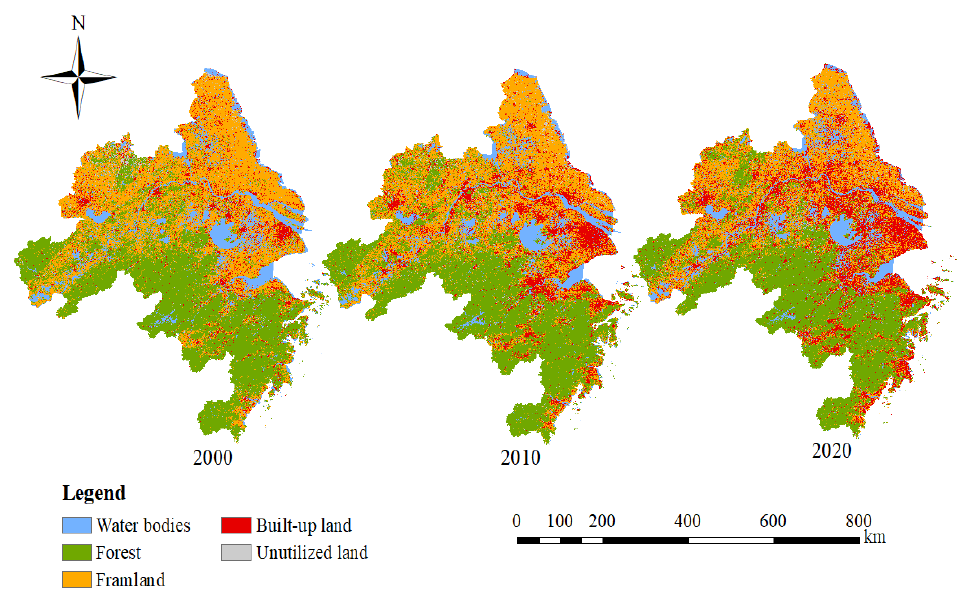
Figure 3. LULC map of YRDAU from 2000 to 2020.